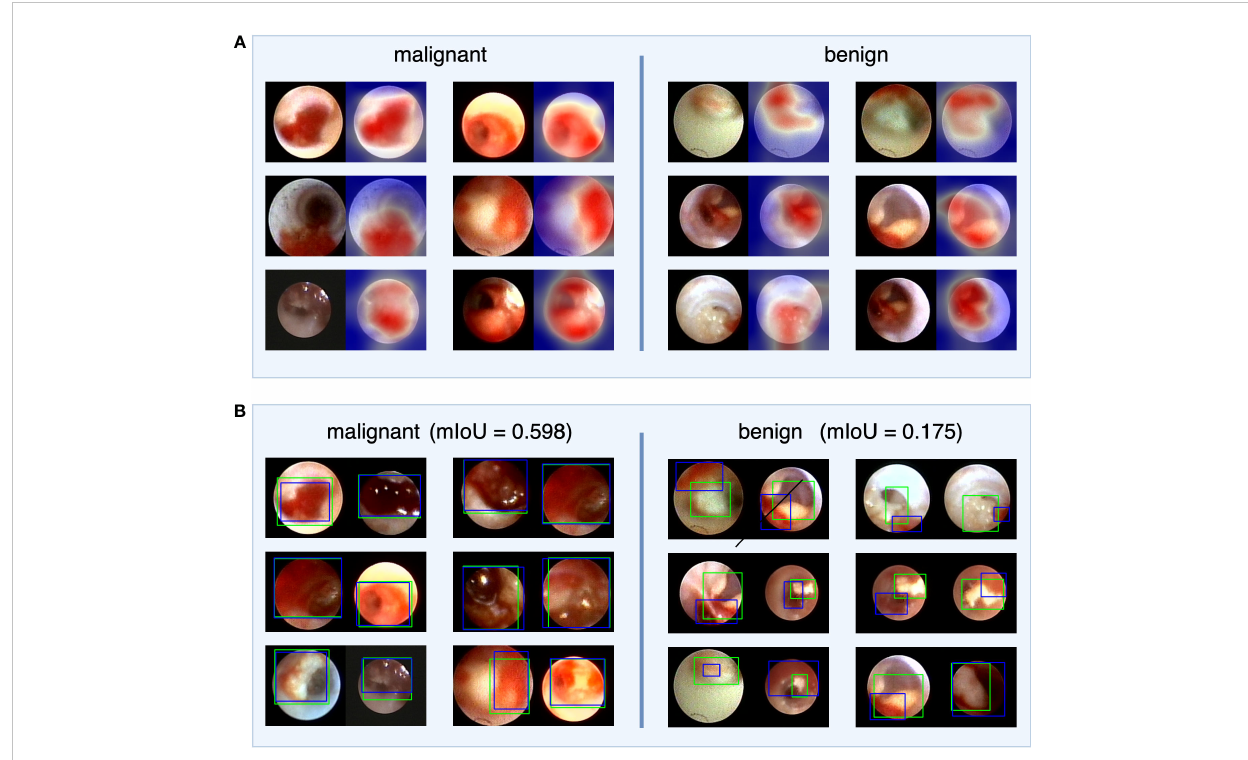
FIGURE 4 The visual explanation of IDBCS. The part (A) of this fi gure shows the decision-supported regions. For each image pair, the left image is the original ductoscopy image and the right image is the heatmap. In the heatmap, the red regions are the important regions that support the diagnosing result of IDBCS. In part (B) of this fi gure, the blue rectangle represents the annotated hemorrhage area and the green rectangle represents the decision- supported area. As we can see in this fi gure, the decision-supported area and the hemorrhage area has a higher mIoU in malignant tumors. This phenomenon means that the hemorrhage is an important reason for malignant tumor